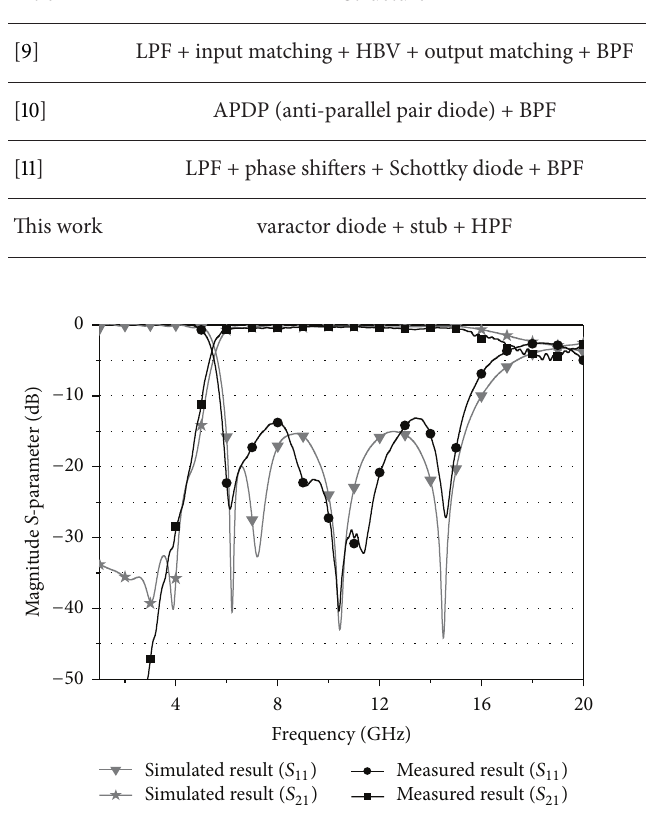
Figure 7: Simulated and measured results of the fabricated high- pass filter.